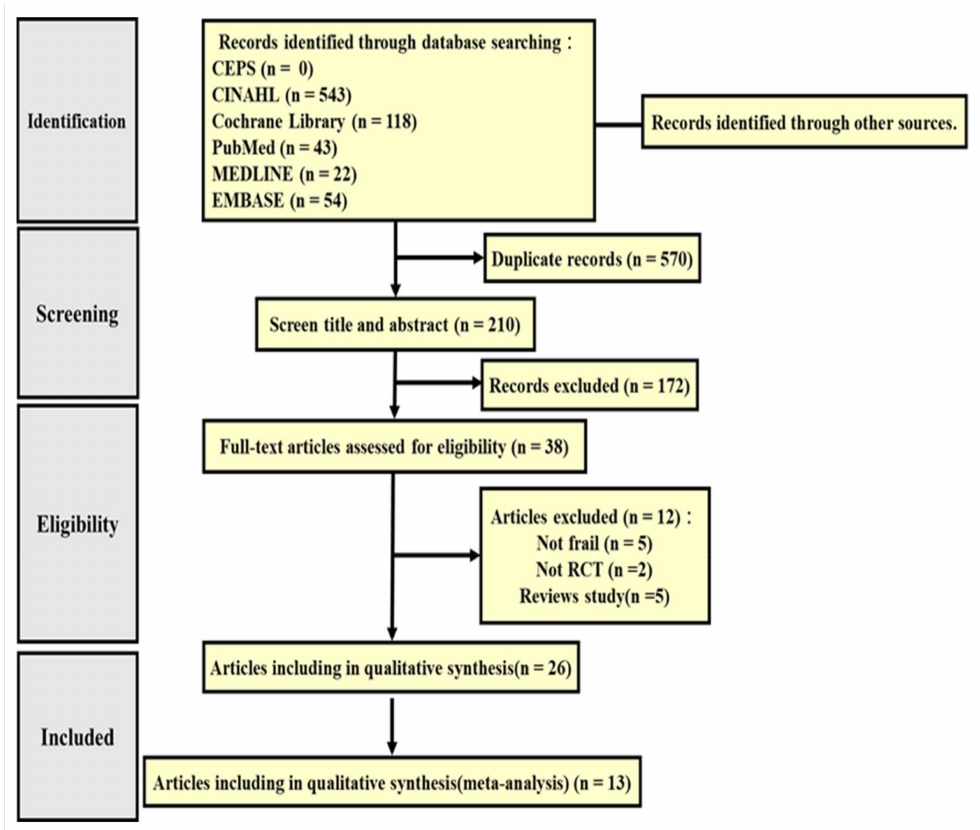
Figure 1. RISMA flow